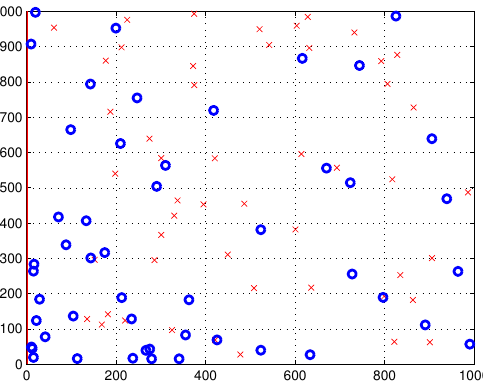
Figure 6. Non-uniformly distributed outdoor and indoor users inside S , denoted as blue circles and red crosses,